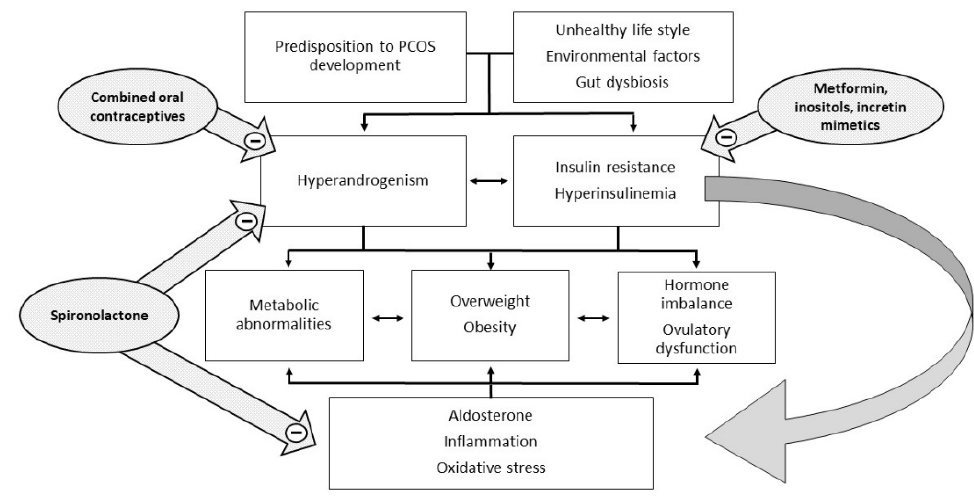
Figure 1. Pathophysiology and potential therapeutic targets of PCOS.